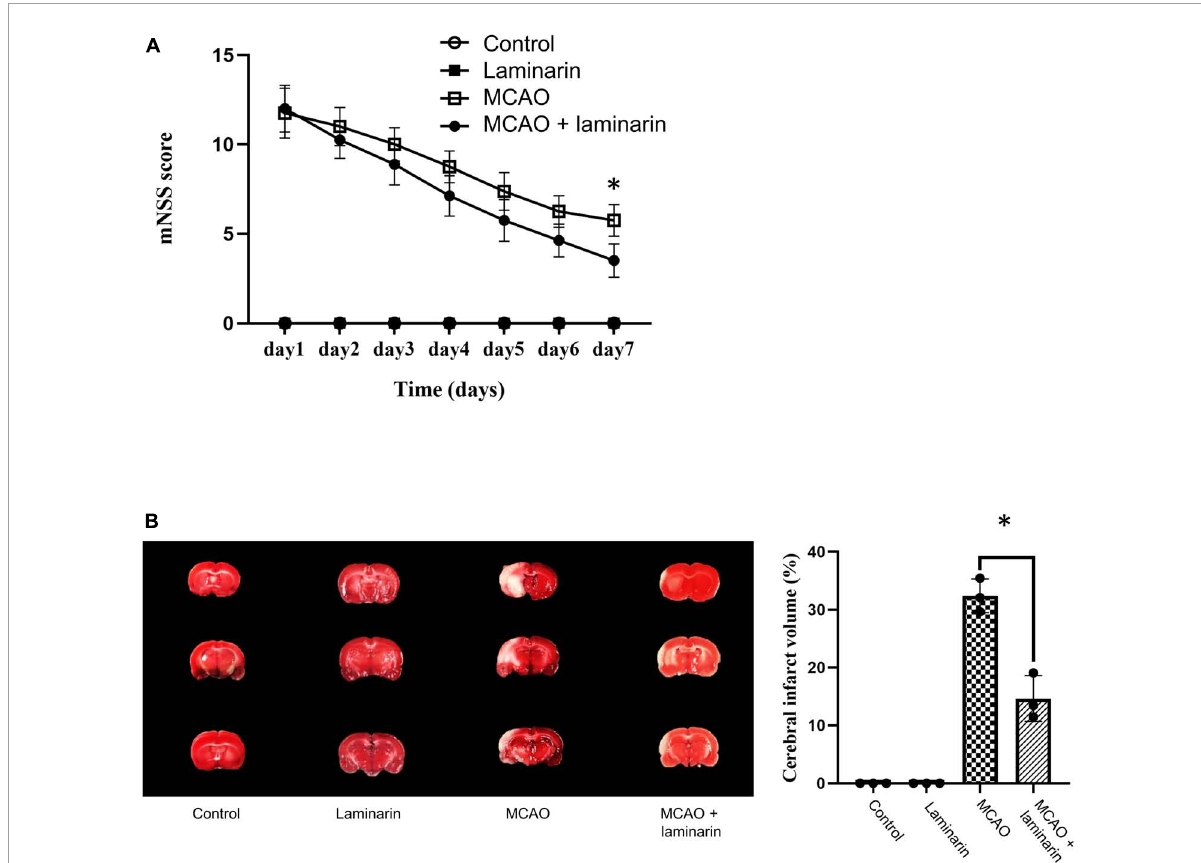
FIGURE1 Laminarin treatment reduced the neuro-deficits in MCAO model. (A) The modified neurologic severity score was used to evaluate the neuro-clinicopathological deficits. The score was higher in the MCAO model and this induction was significantly attenuated after 7 days of laminarin treatment. (B) The infarct volume (white zone) of brain was higher in MCAO model, which was significantly reduced after 7 days of laminarin treatment. N = 8 per condition. *Represented p -value < 0.05 and statistically